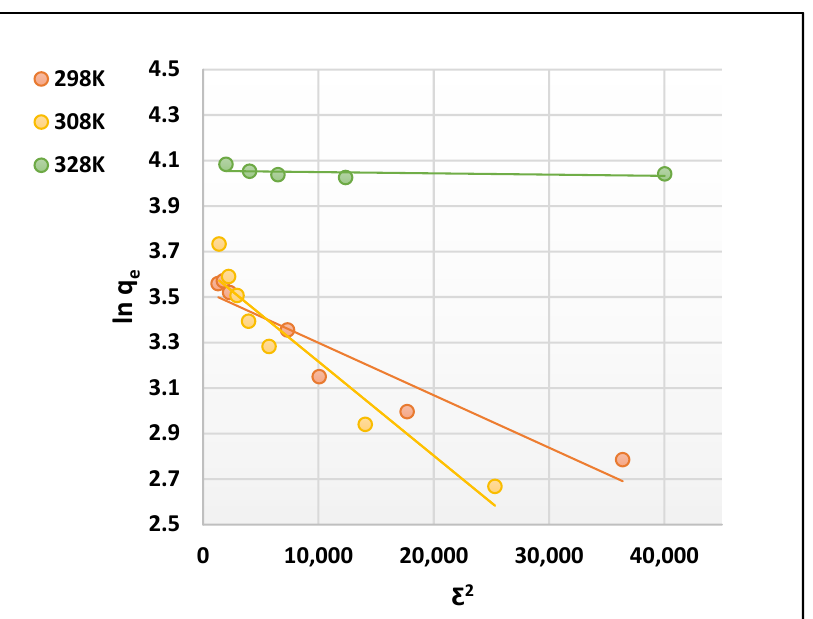
Figure 22. D-R isotherm plots for adsorption of CR dye onto 2Clph-BU-Cs adsorbent (m = 0.01 g, C 0 = 30–120 mg L −1 , V = 100 mL, pH = 4, and time = 48 h). Table 4. Adsorption isotherm constants of CR dye by 2Clph-BU-Cs adsorbent (m = 0.01